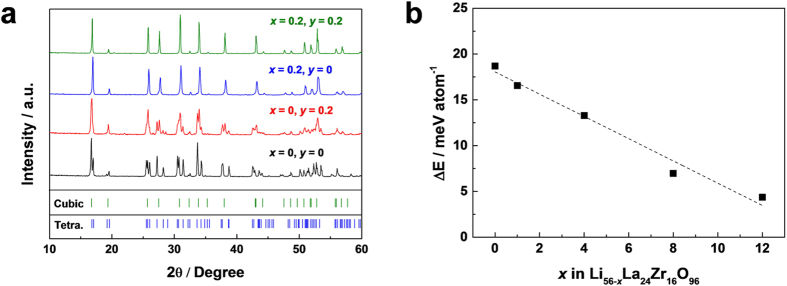
Doping effect on the stabilization of cubic LLZO.(a) XRD patterns of synthesized LLZO power according to doping condition. Dopant species are described with x and y in Li7−3x−yAlxLa3Zr2−yTayO12. (b) Calculated energy difference (ΔE = Ecubic − Etetragonal) between cubic and tetragonal LLZO as a function of Li vacancy x in Li56−xLa24Zr16O96.